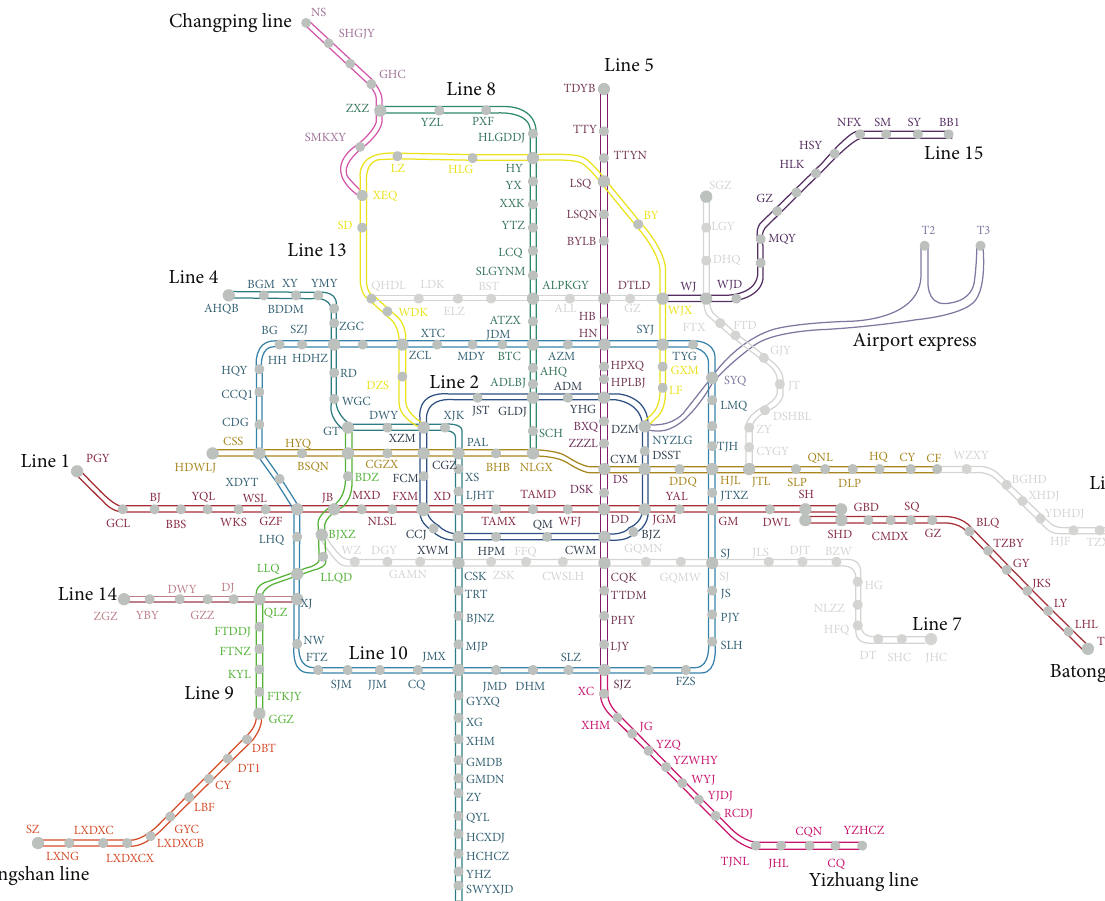
Figure 2: Beijing urban rail transit network (April, 2014).